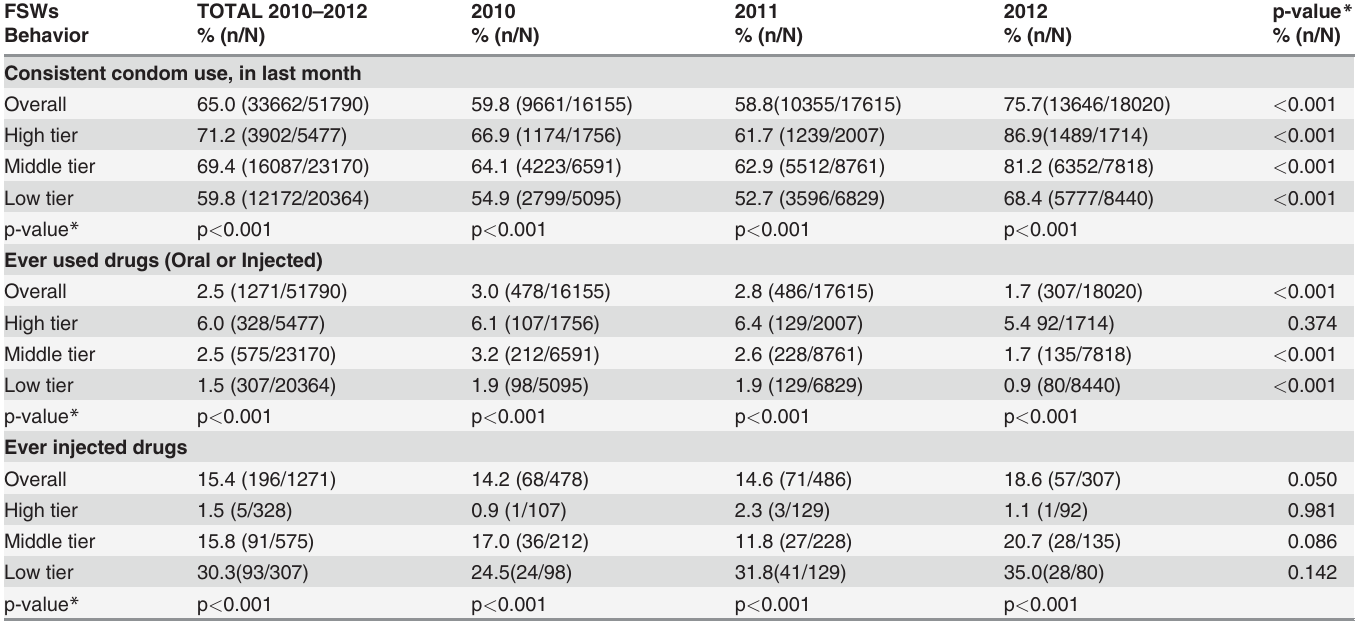
(Table 4,Demographic and risk factors correlations of HIV or syphilis infection among female sex workers (FSW), Guangxi province, China, China National CDC HIV/AIDS Surveillance Data, 2010 – 2012).